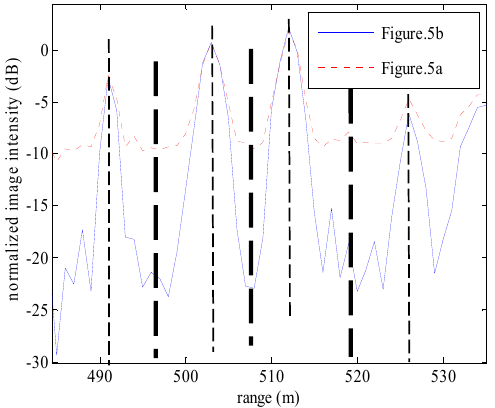
Figure 6. Image intensities along the white lines in Figure 5a (red dotted line) and Figure 5b (blue solid line).